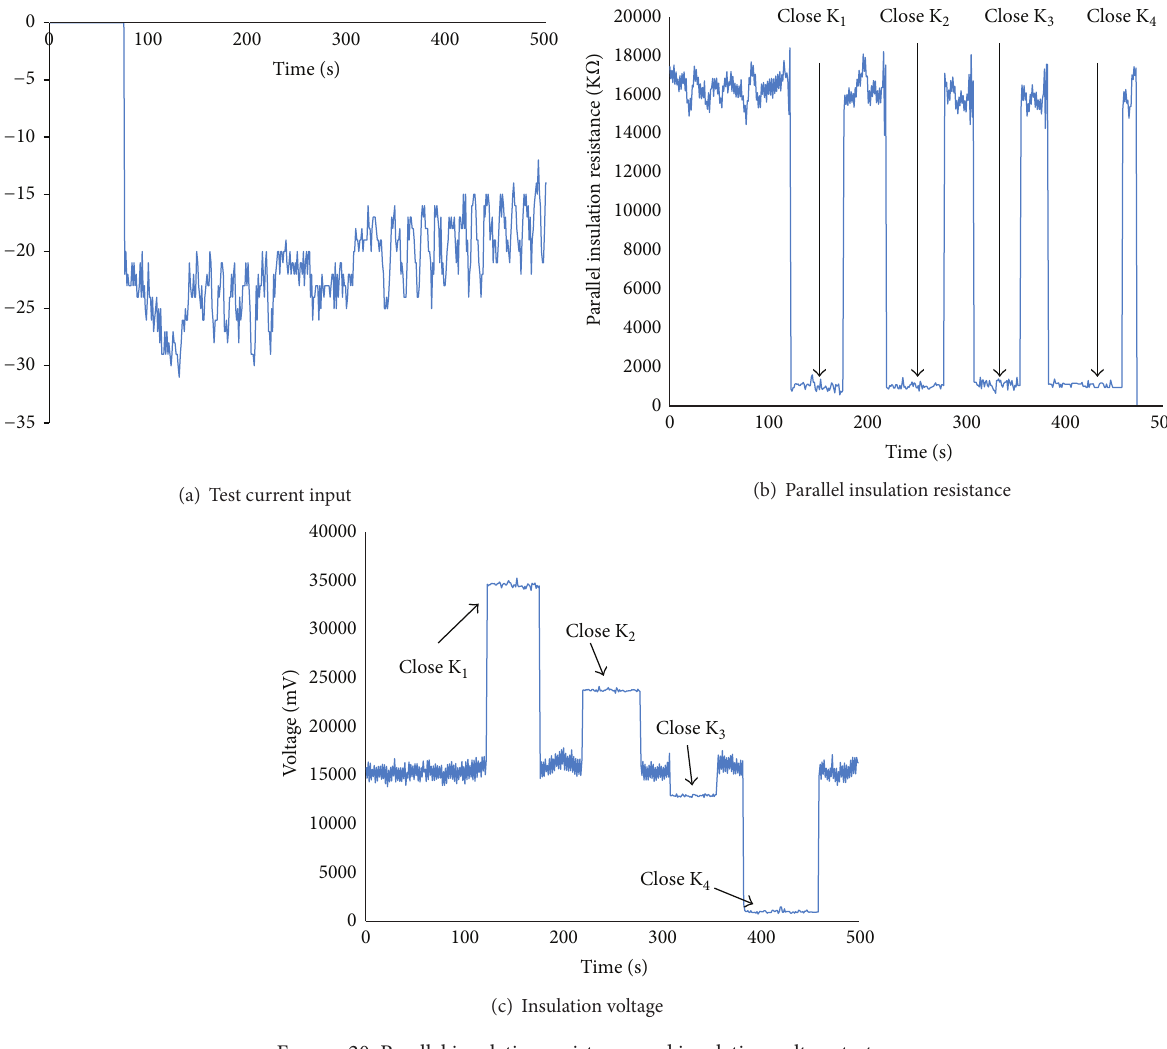
Figure 20: Parallel insulation resistance and insulation voltage